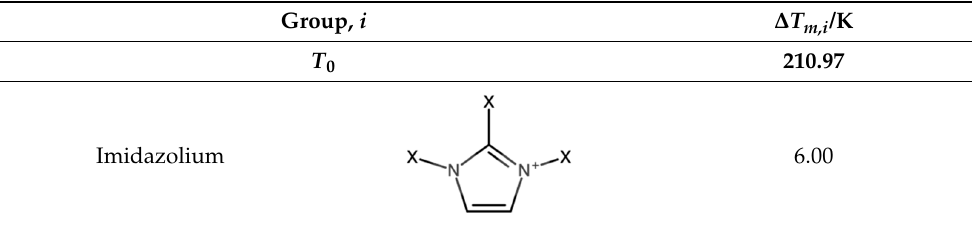
Table 2. New and reparametrized cation functional group parameters for GCM1-R.